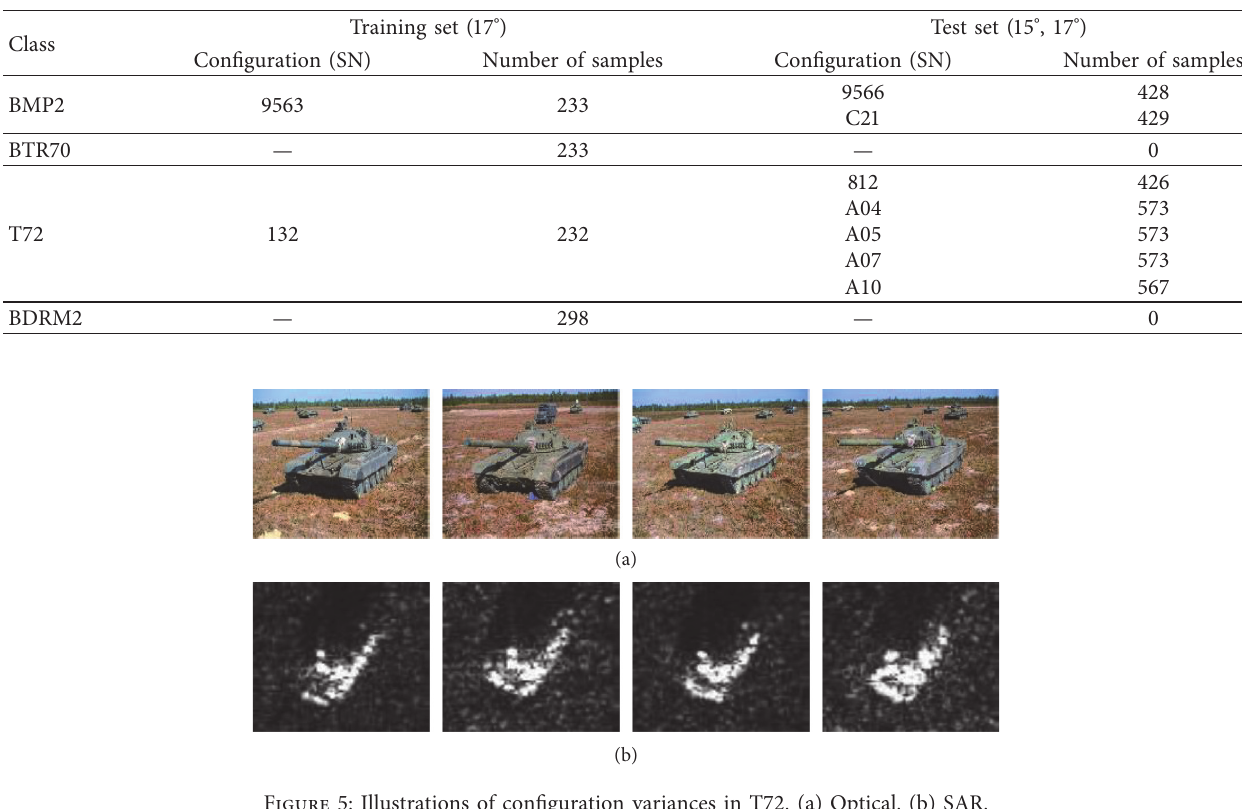
Table 3: Training and test samples under configuration variance.